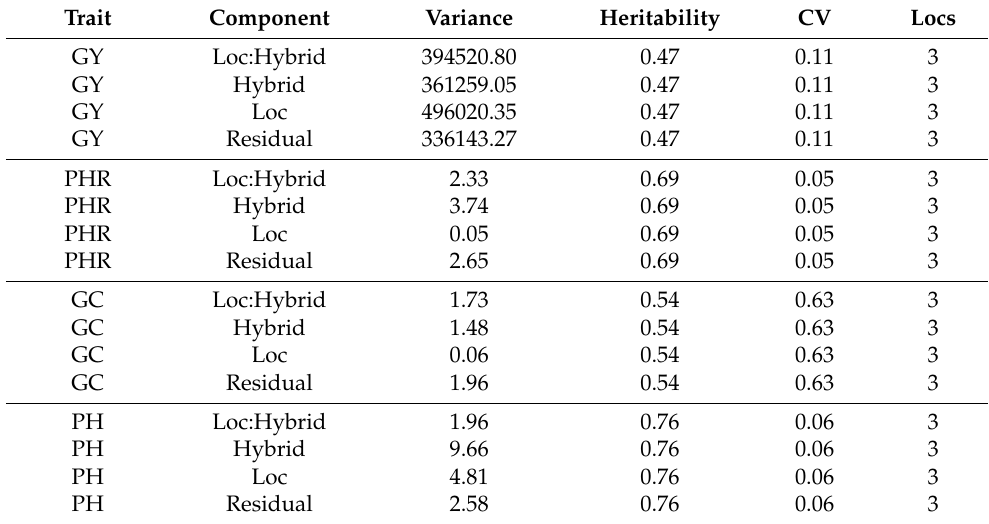
Table 1. Variance components (variance) and heritability estimates for dataset 1 ( Indica ) for each trait. CV denotes coefficient of variation, and Locs denotes the average number of locations. Trait Component Variance